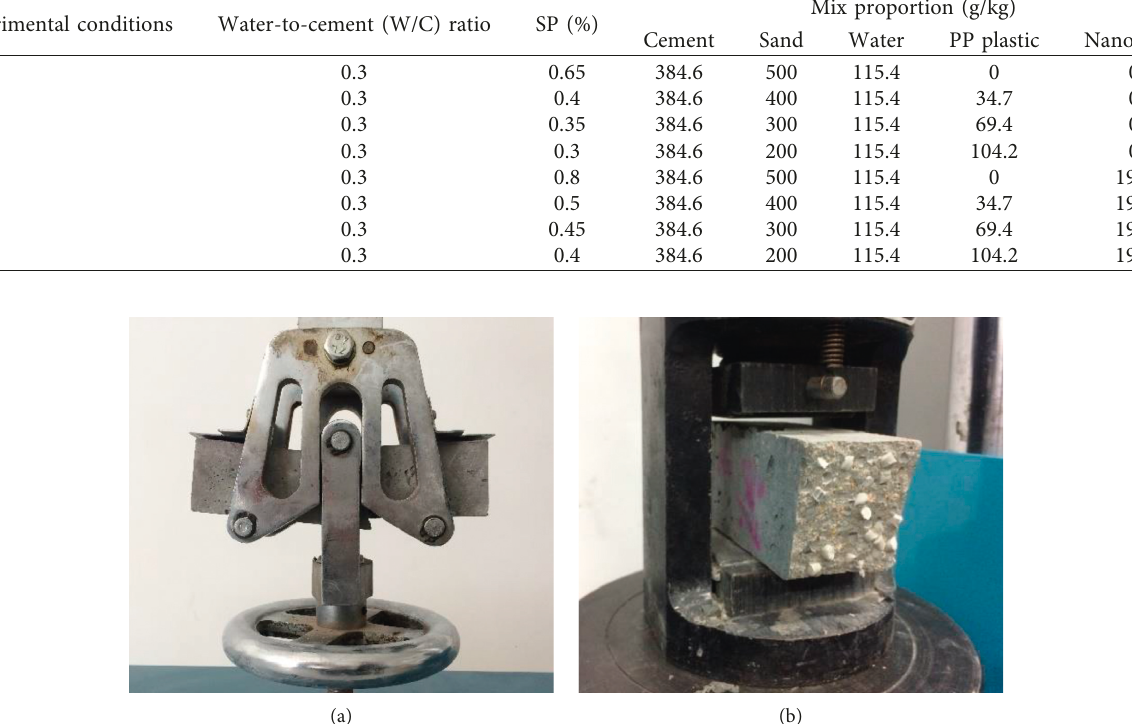
Figure 2: Flexural and compressive strength test of PP-filled mortar specimens.